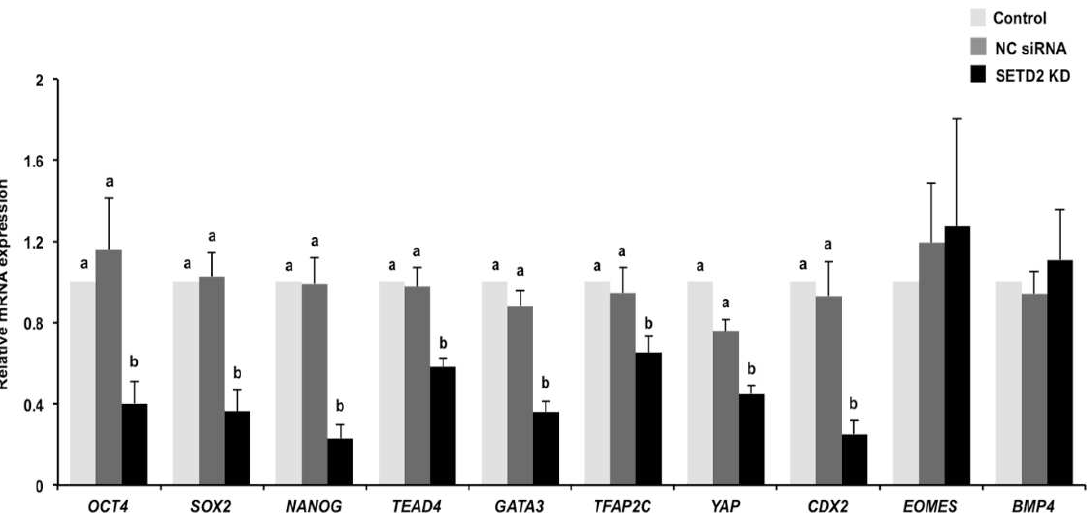
Figure 5. SETD2 KD affected the expression of cell differentiation genes. Expression of genes required for the ICM and TE lineage specification in blastocysts from each group. Expression levels of the indicated genes was analyzed by qPCR. The independent experiment was carried out for three times and 30 embryos in each group were at least included. The data are presented as mean ± S.E.M and different letters indicate significant differences ( p < 0.05).